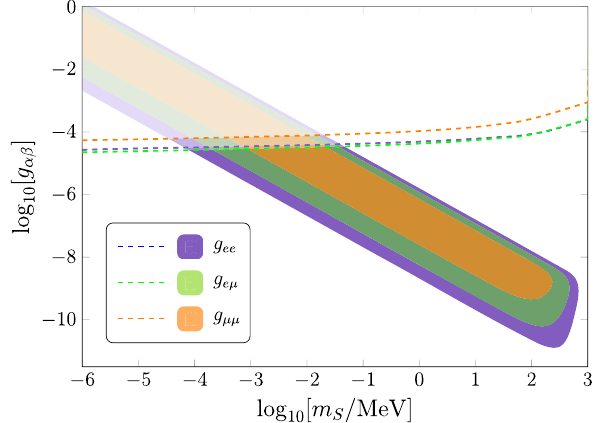
Fig. 3 The parameter range excluded by supernova cooling consid- eration for a scalar, S , coupled to neutrinos. In the region above the dashed lines, the new particle gets trapped inside the supernova and the obtained bounds do not apply. Figure taken from Ref.